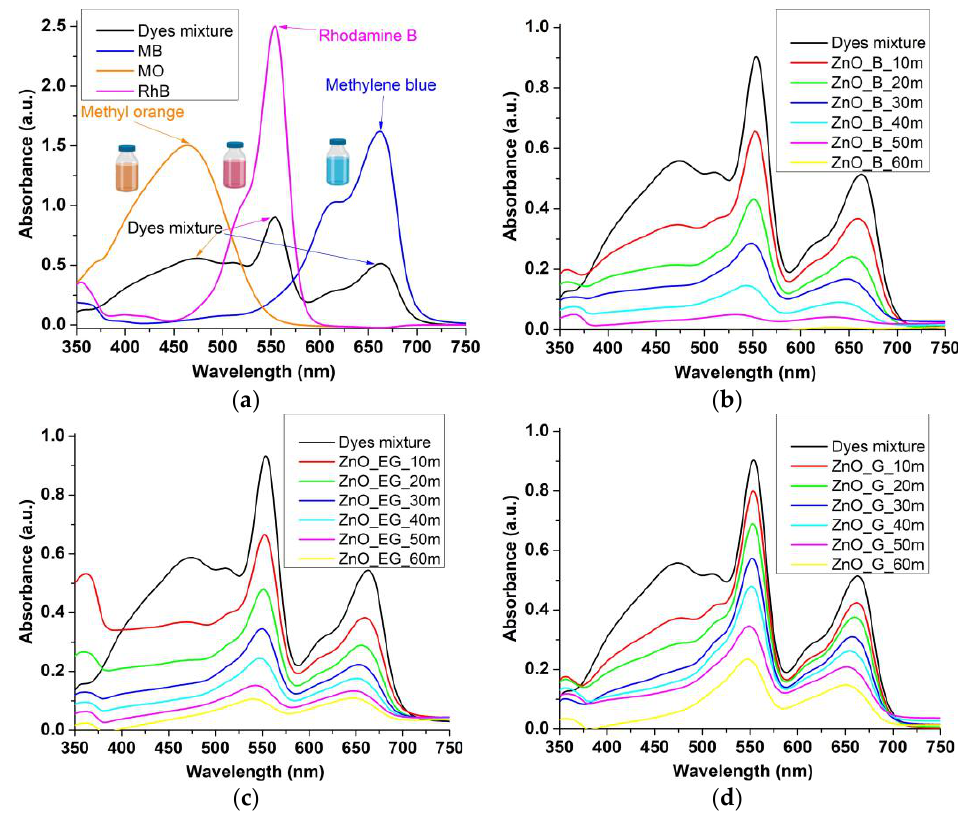
Figure 9. Absorption spectra for individual dyes, methylene blue (MB), Rhodamine B (RhB) and methyl orange (MO) and for dyes mixture (MB + RhB + MO), with indication of the corresponding absorption maxima ( a ); photocatalytic activity of ZnO_B sample against dyes mixture ( b ); photocatalytic activity of ZnO_EG sample against dyes mixture ( c ); photocatalytic activity of ZnO_G sample against dyes mixture ( d ).